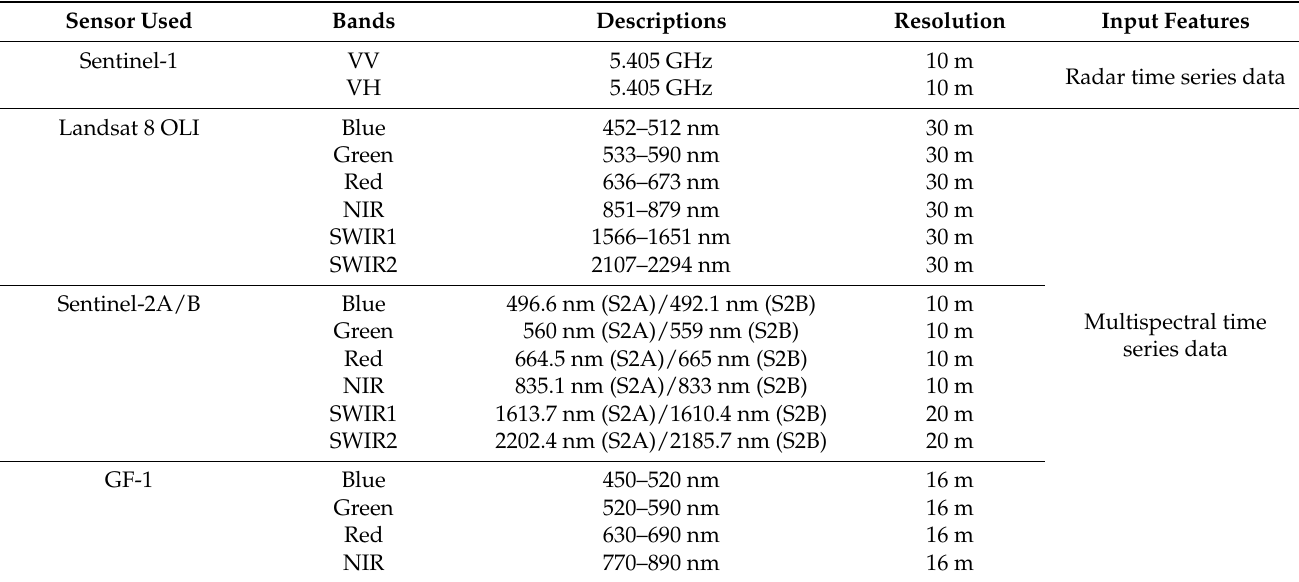
Table 1. Description of the remote sensing data used in this study.